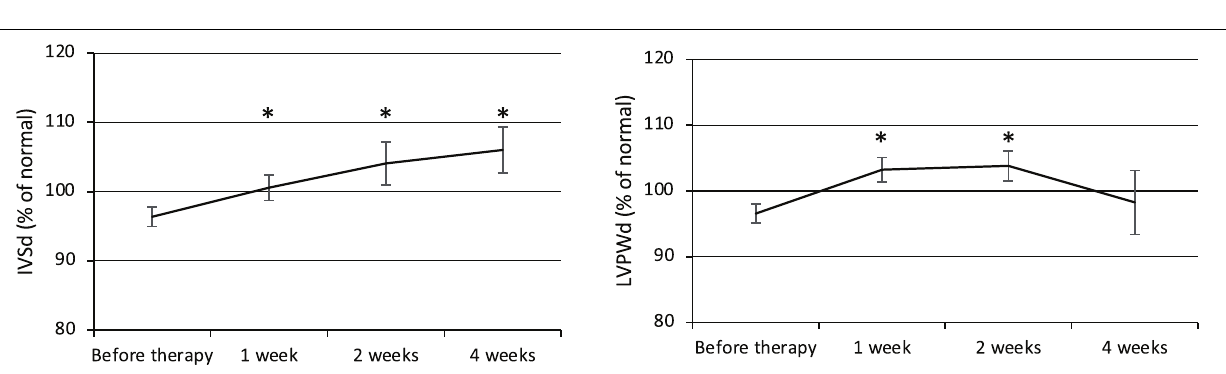
FIGURE 2 | Changes in ventricular wall thickness (IVSd and LVPWd). IVSd, Interventricular septal end-diastolic thickness. LVPWd, Left ventricular posterior wall end-diastolic diameter. ∗ p < 0.05 for comparisons with pretherapy values. The line graph connects the mean values, and the error bars show the standard error ranges. Both the IVSd and LVPWd increased in thickness after 1